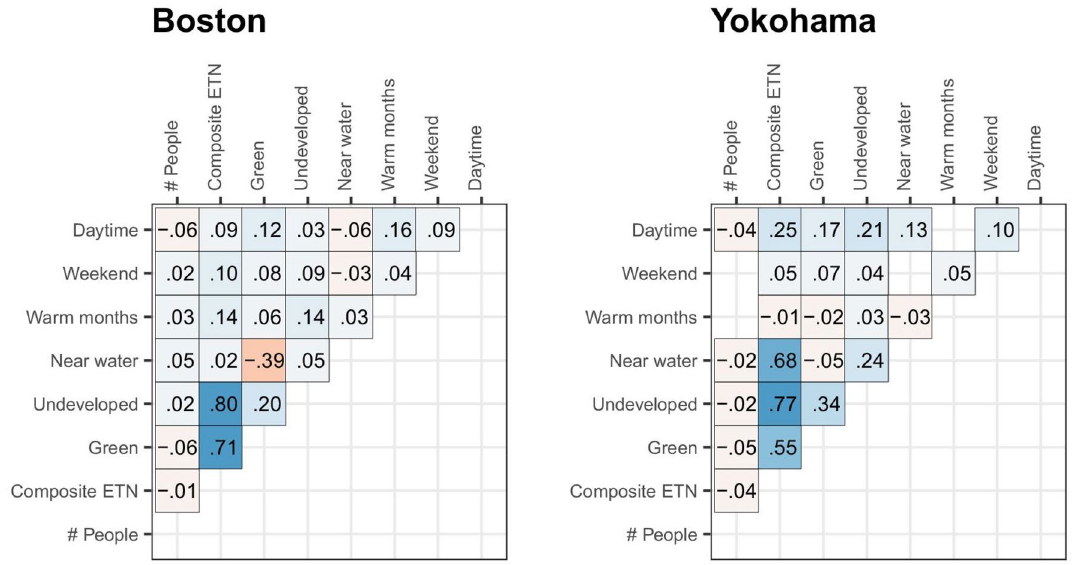
Figure 2. Pearson correlation values between explanatory variables, separately for each of the two studied regions. Non-significant ( p > 0.05) coefficients are not